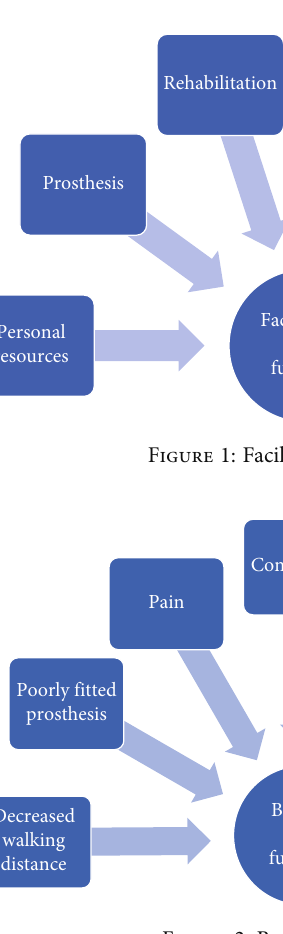
Figure 2: Barriers for